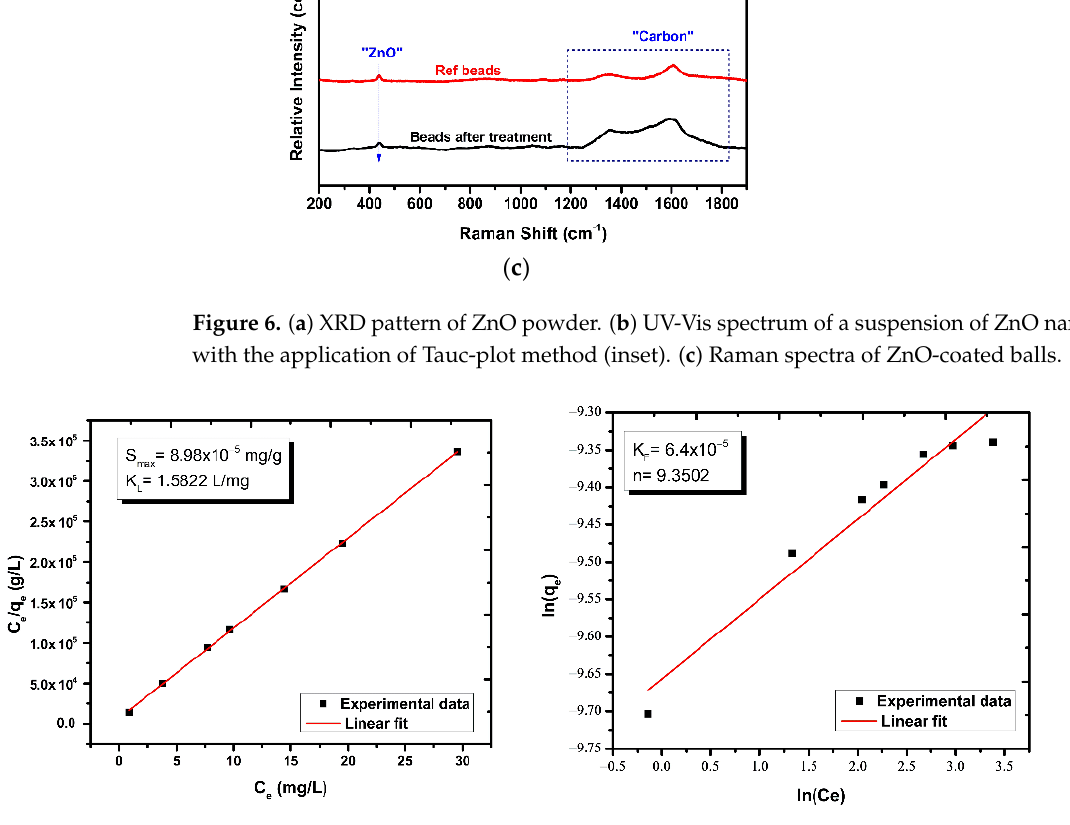
Figure 6. ( a ) XRD pattern of ZnO powder. ( b ) UV-Vis spectrum of a suspension of ZnO nanoparti- cles with the application of Tauc-plot method (inset). ( c ) Raman spectra of ZnO-coated balls.